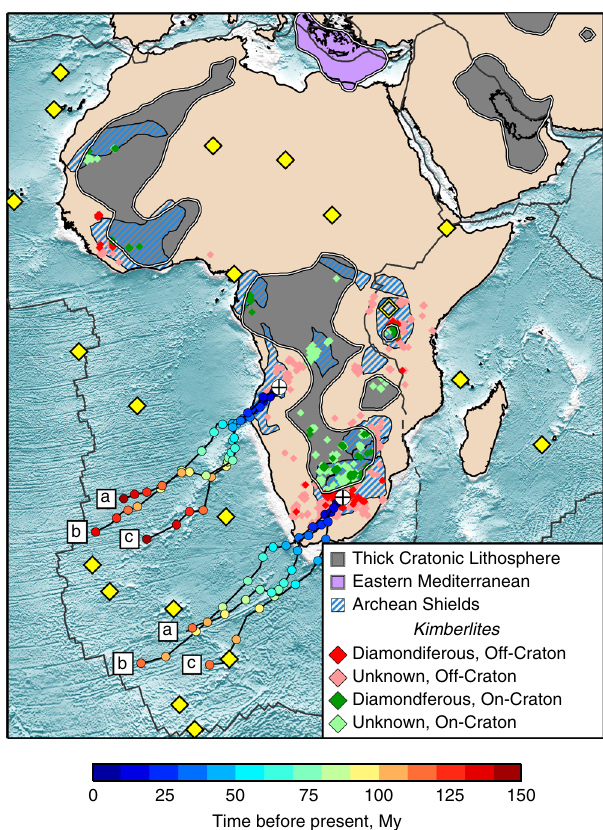
Fig. 5 Preserved and eroded cratonic lithosphere beneath Africa and Arabia. The thick lithosphere present today is shown in grey. The grey areas include all locations with shear-velocity anomaly exceeding + 5% in the 80 – 150 km depth range, which indicates cold, thick cratonic lithosphere (except in eastern Mediterranean where the high velocities show a part of the Hellenic slab and the exceptionally thick, Triassic oceanic lithosphere). Geologically mapped Archean shields 20 are shown with blue and white stripes. Kimberlites and lamproites atop thick lithosphere at present are distinguished from those atop thinned lithosphere. The latter (red, pink) are indicators of lithospheric erosion. Locations of two now eroded cratons (white crossed circles) are reconstructed back in time following three different plate-tectonic reconstructions: a 73 , b 72 , c 67 . Present-day hotspot locations are shown as solid yellow diamonds; the southern, Tanzania end of the elongated EARS anomaly — as empty